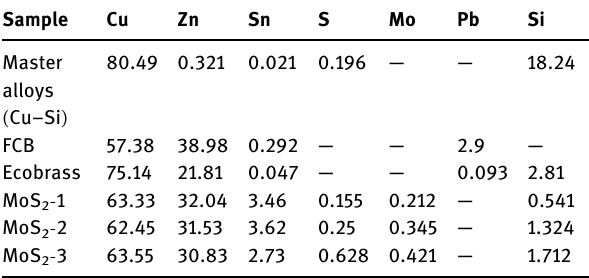
Table 2: Chemical compositions of